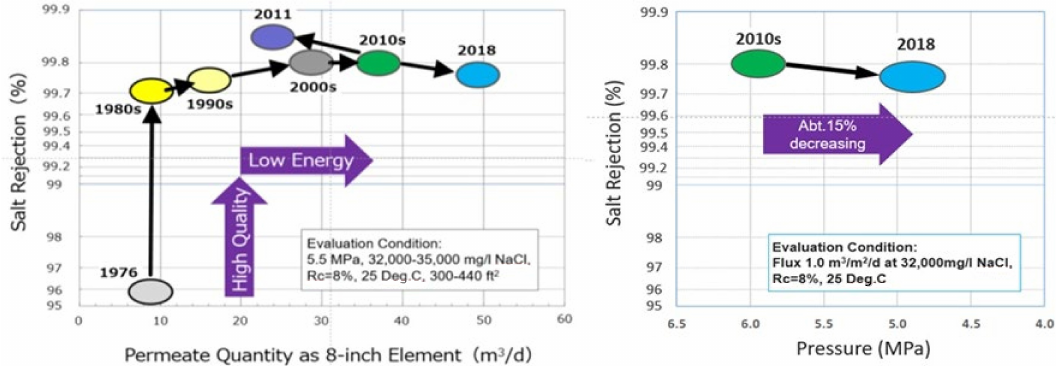
Figure 12. History of the high-performance SWRO membrane: Toray “ROMEMBRA” SWRO Membrane and new advanced low pressure SWRO membrane [15,20].